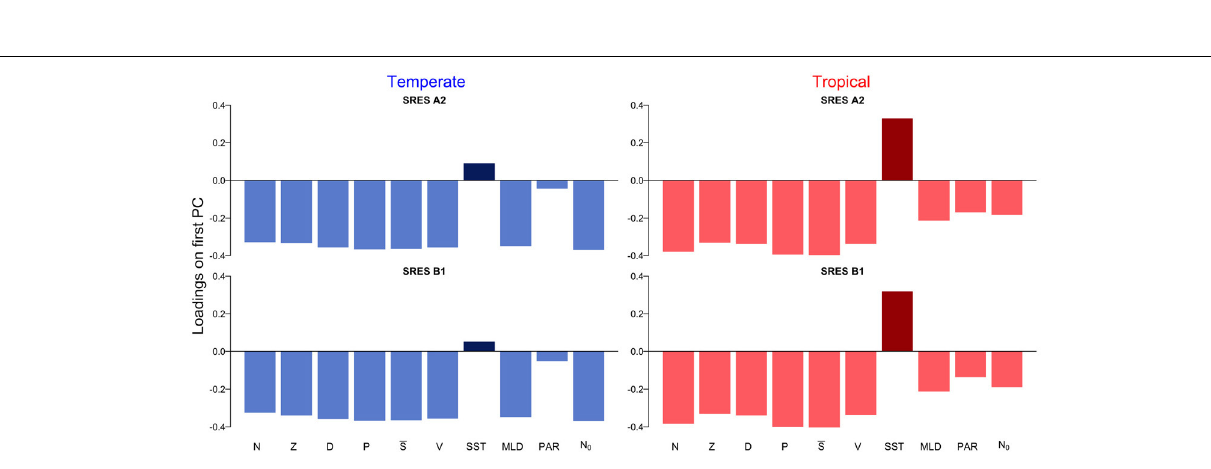
FIGURE 4 | Loadings on the first principal component for temperate and tropical regions under the SRES A2 and SRES B1 emission